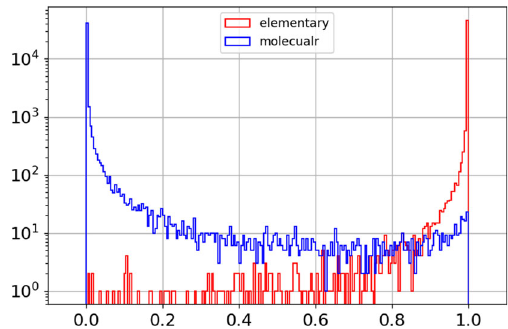
Fig. 4 Output distributions of test